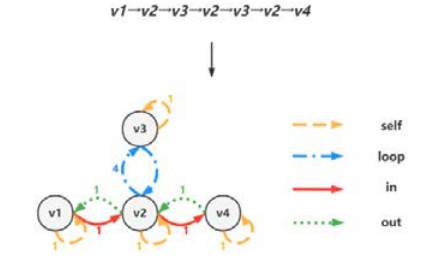
Fig. 2. This figure describes the process of session sequences to graphs. The obtained graph model can distinguish items with different relationships and record the frequency of